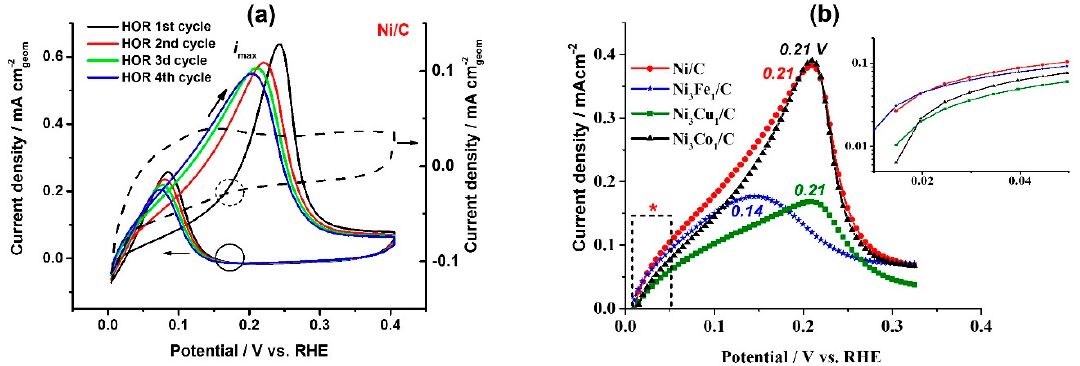
Figure 2. ( a ) Hydrogen oxidation reaction (HOR) polarization curves (solid lines) and cyclic voltammogram (dashed line) for the Ni/C catalyst. The arrows show the potential sweep direction. ( b ) Comparison of the HOR polarization curves (forward scans) for monometallic Ni/C and bimetallic Ni 3 TM 1 /C catalysts for TM = Fe, Co and Cu. The numbers correspond to the peak potential values. * Potential range of 0.01–0.05 V used for the kinetic analysis.